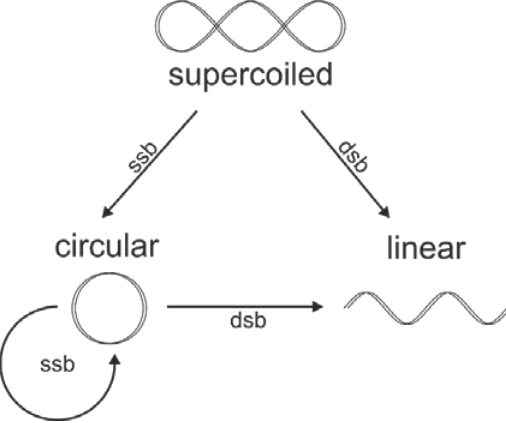
Figure 3. Schematic representation of the radiation induced topological changes in plasmid DNA [42]. The ssb and dsb correspond to single-strand and double-strand breaks, respectively.